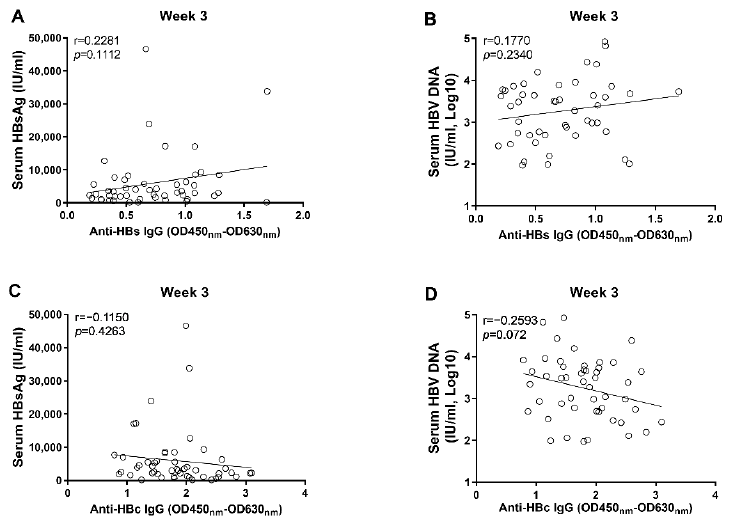
Figure 5. The correlation analyses between anti-HBc/anti-HBs IgG responses and markers of HBV replication at 3 wpi. ( A ) the correlation between levels of anti-HBs IgG and concentrations of serum HBsAg; ( B ) the correlation between levels of anti-HBs IgG and concentrations of serum HBV DNA; ( C ) the correlation between levels of anti-HBc IgG and concentrations of serum HBsAg; ( D ) the correlation between levels of anti-HBc IgG and concentrations of serum HBV DNA. Statistical analysis was performed by the method of Pearson correlation ( n = 50).